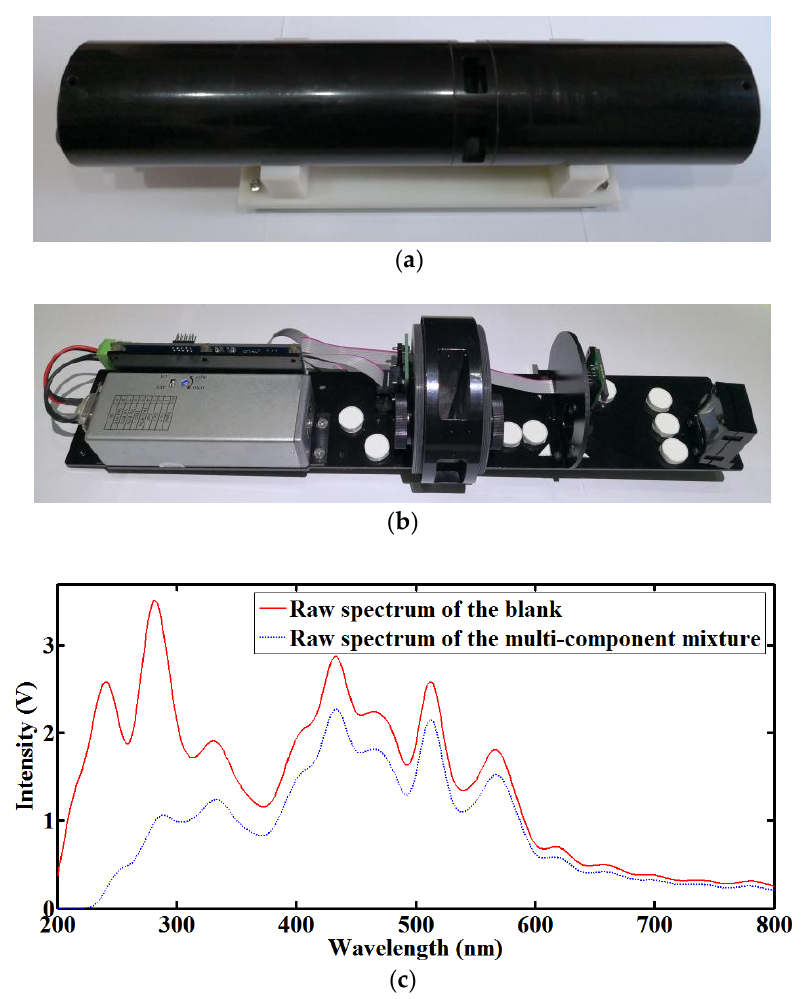
Figure 2. The prototype of the UV-visible spectrometer probe: ( a ) The outside view; ( b ) The internal structure; ( c ) The typical raw spectra of the blank and the multi-component mixture.